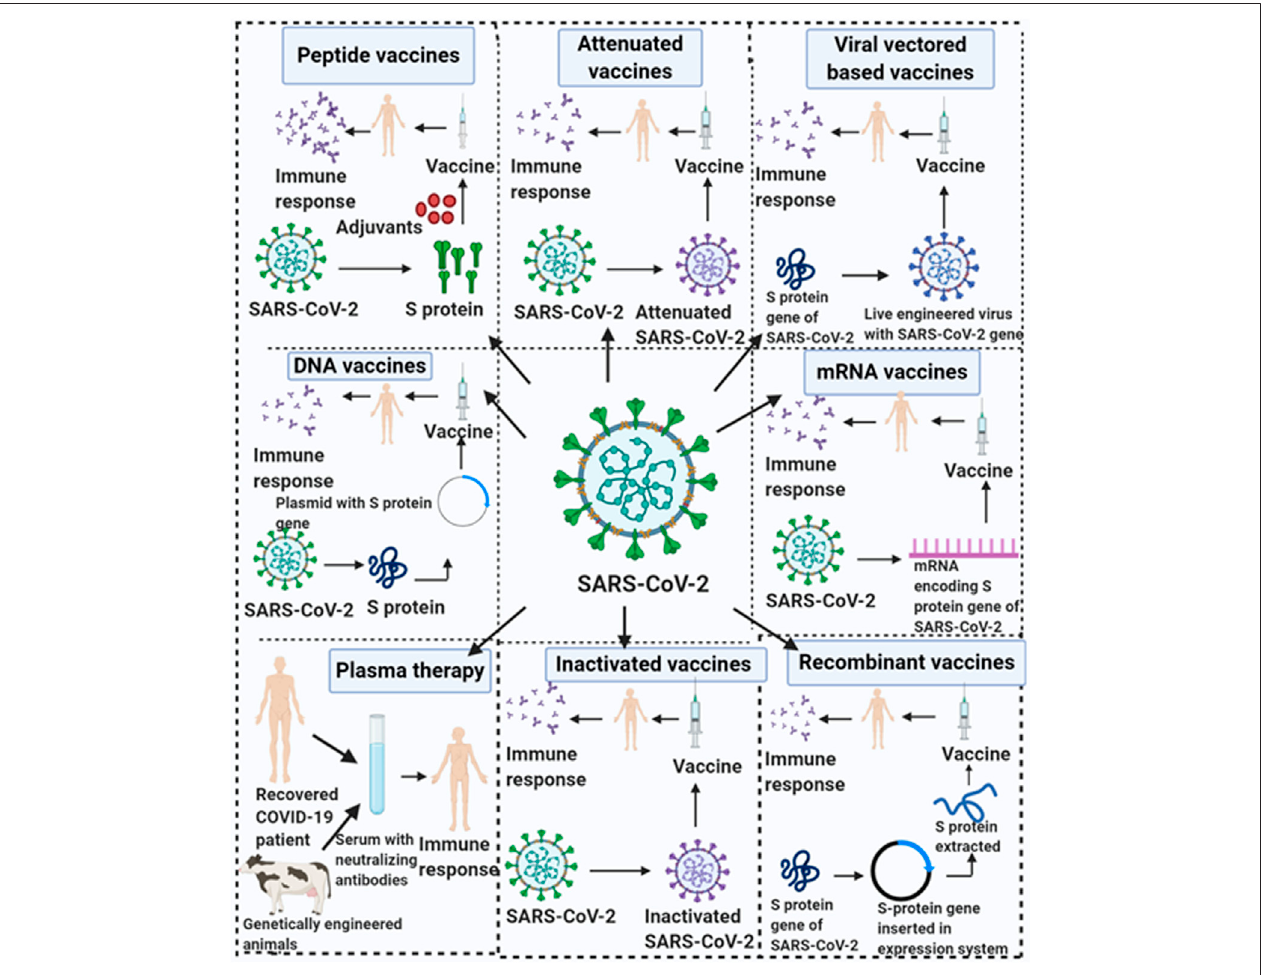
FIGURE 5 | Overview of vaccine design and